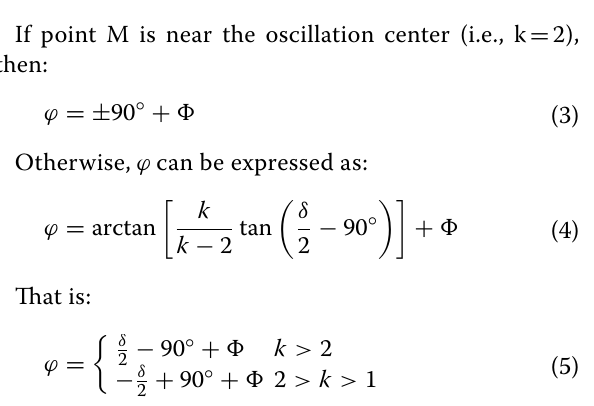
Fig. 3 Phasor diagram of voltage and current on the